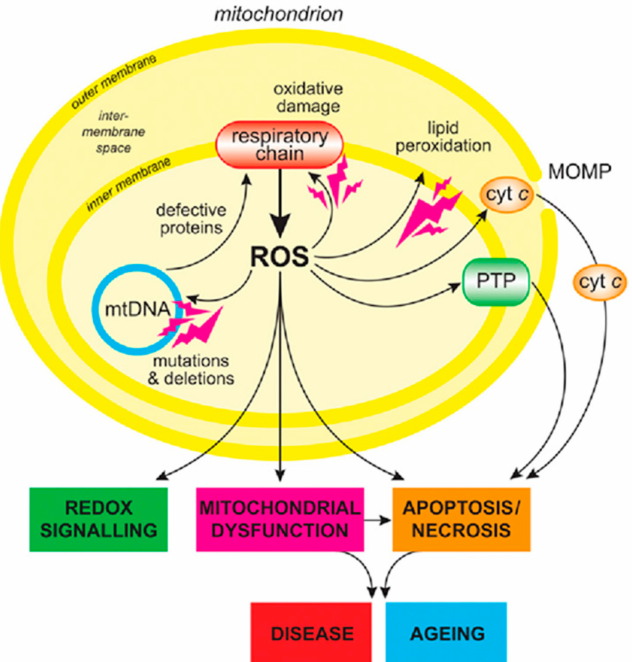
Figure 1. Genesis of ROS in mitochondria and its fate [5]. Cells apoptotic cycle is activated when mitochondrial DNA (mtDNA) undergoes damage due to the increased intra-mitochondrial ROS surge. The sequence of events triggered after oxidative damage are: (1) Cytochrome C permeates out of mitochondria by the outer membrane permeabilization (MOMP), (2) intra mitochondria ROS surge fuel the production of mitochondrial permeability transition pore (PTP). This event increases the susceptibility of the mitochondrial permeability to the small molecules leading to cell apoptosis and subsequent